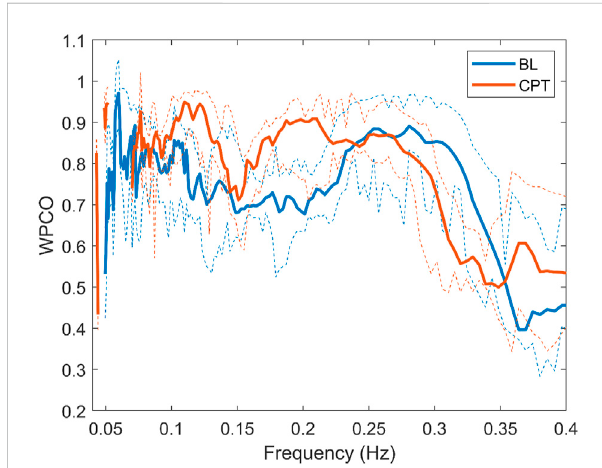
FIGURE 6 Wavelet phase coherence of RR interval and systolic blood pressure for the normotensive non-pregnant group during baseline (BL) and cold pressor test (CPT) in terms of median and 95% CI.